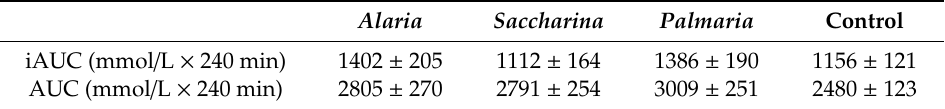
Table 4. Area under the curves (AUCs) and incremental AUCs (iAUCs) during an oral glucose tolerance test (OGTT) in the KK-Ay performed at week 11 of the intervention with diets supplemented with either Alariaesculenta , Saccharinalatissima, or Palmaria palmata compared to chow (control). No significant differences between groups were found. Means ± SEM are shown.